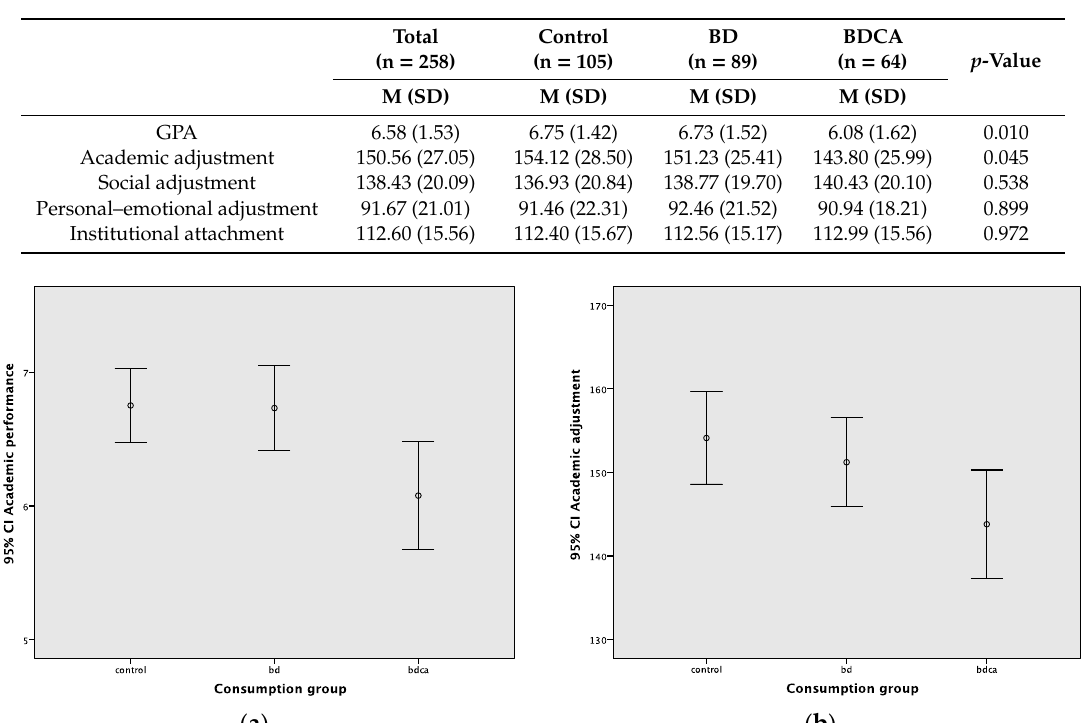
Table 2. Academic performance and adjustment in the overall sample and each group of participants. Means (M), standard deviations (SD) and p -value.